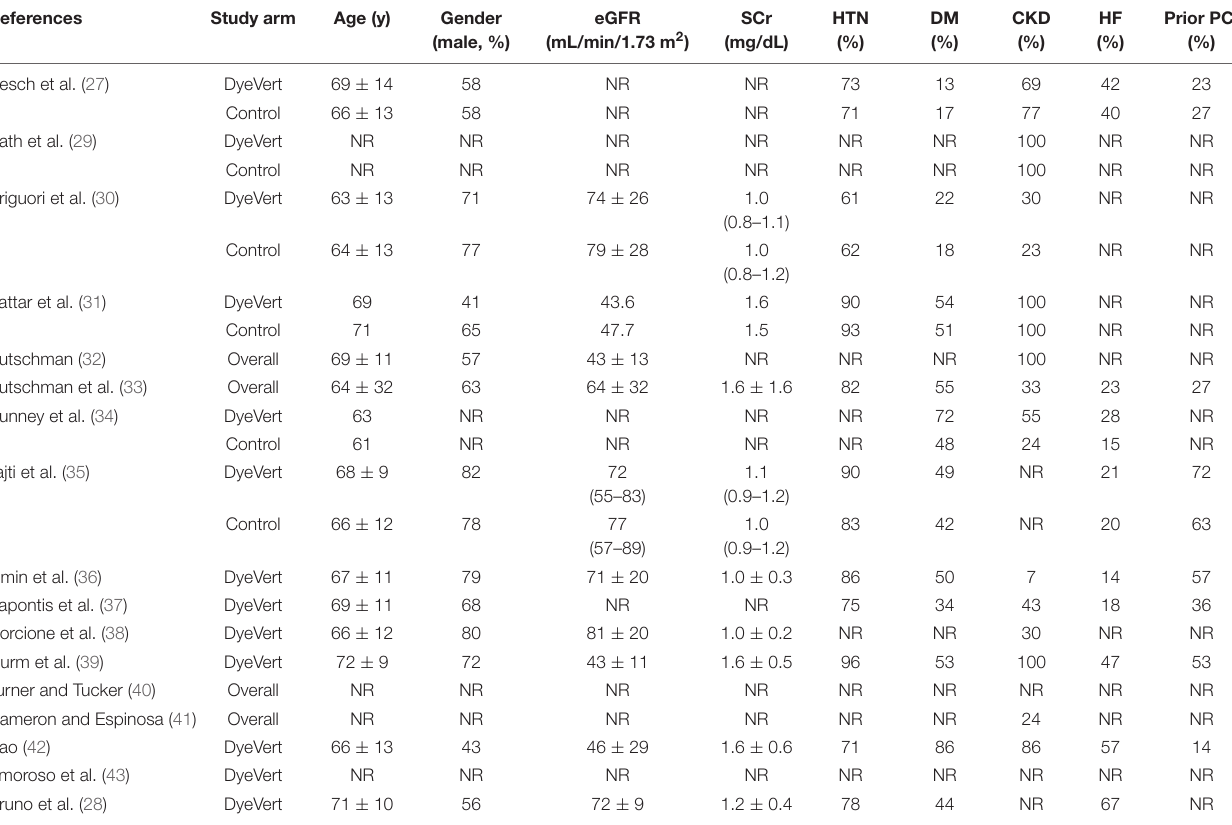
TABLE 2 | Baseline clinical characteristics across included